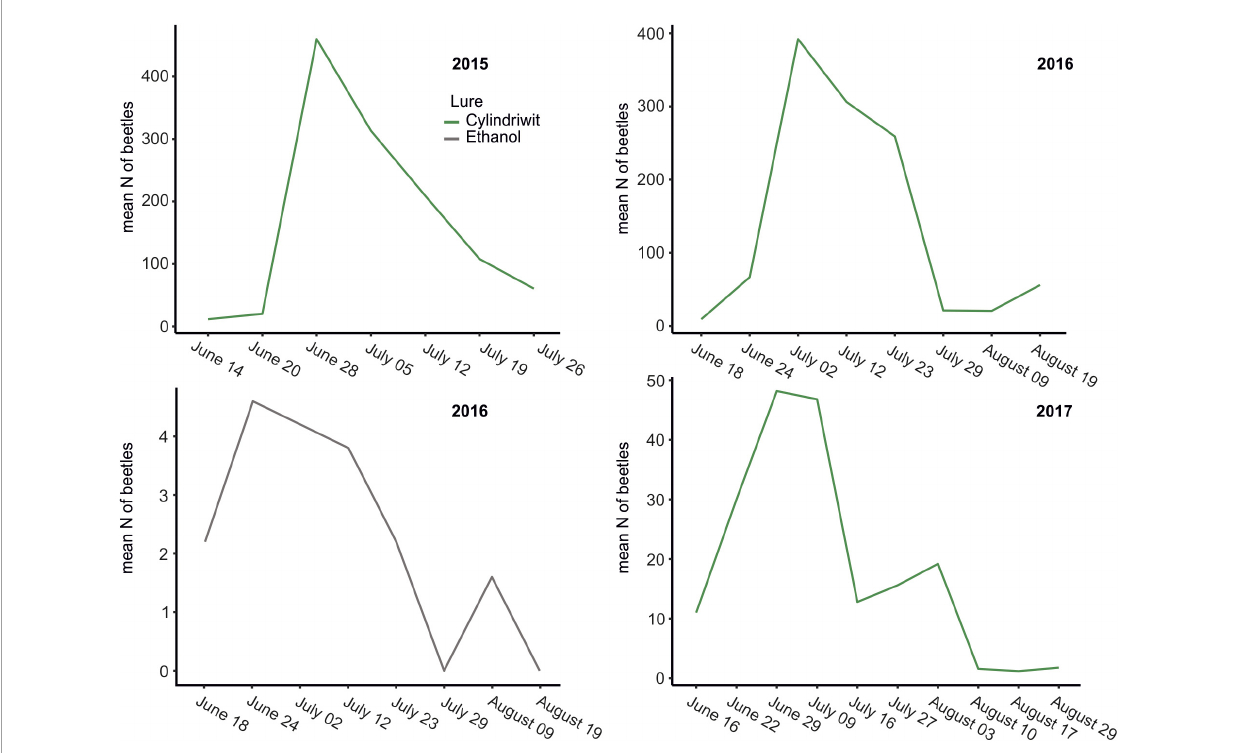
FIGURE3 The oak pinhole borer catches to lure and ethanol baited traps from 2015 to 2017 in the Czechia. Green line ... Cylindriwit baited traps, gray line ... ethanol baited traps.